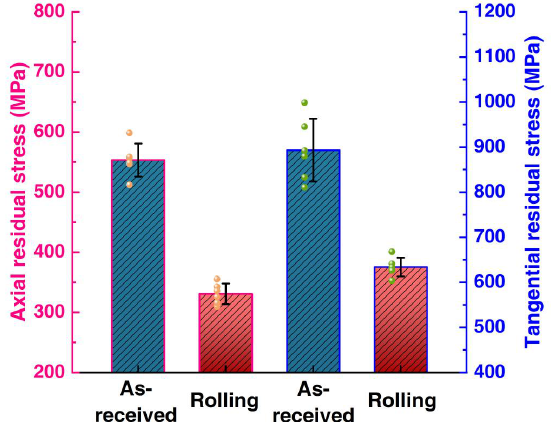
Figure 7. Average tangential and axial residual stresses (MPa), with their standard deviations measured at the surface of the thread after turning and rolling. Each measurement is marked as a point on the corresponding bar.